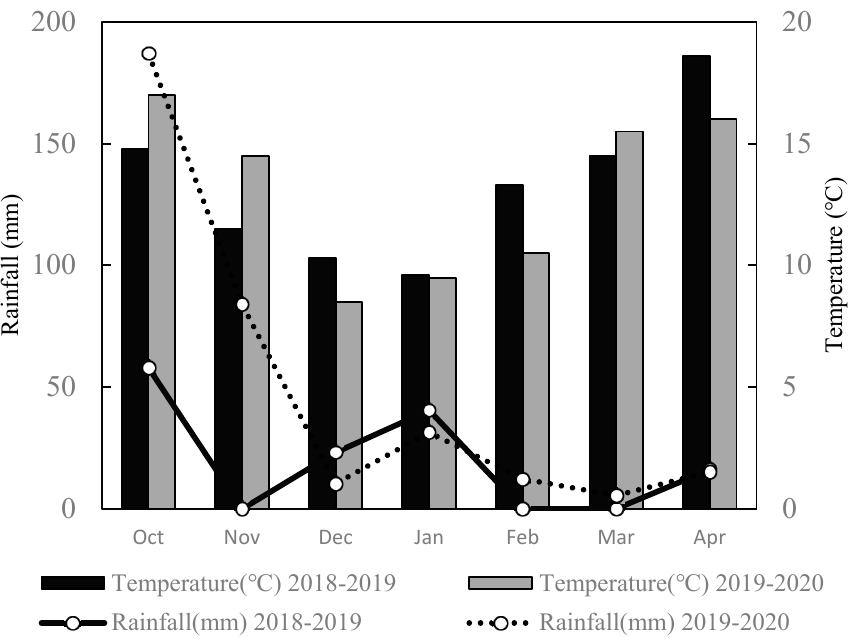
Figure 1. The monthly average temperature and rainfall during experiments of 2018 – 2019 and 2019 – 2020.